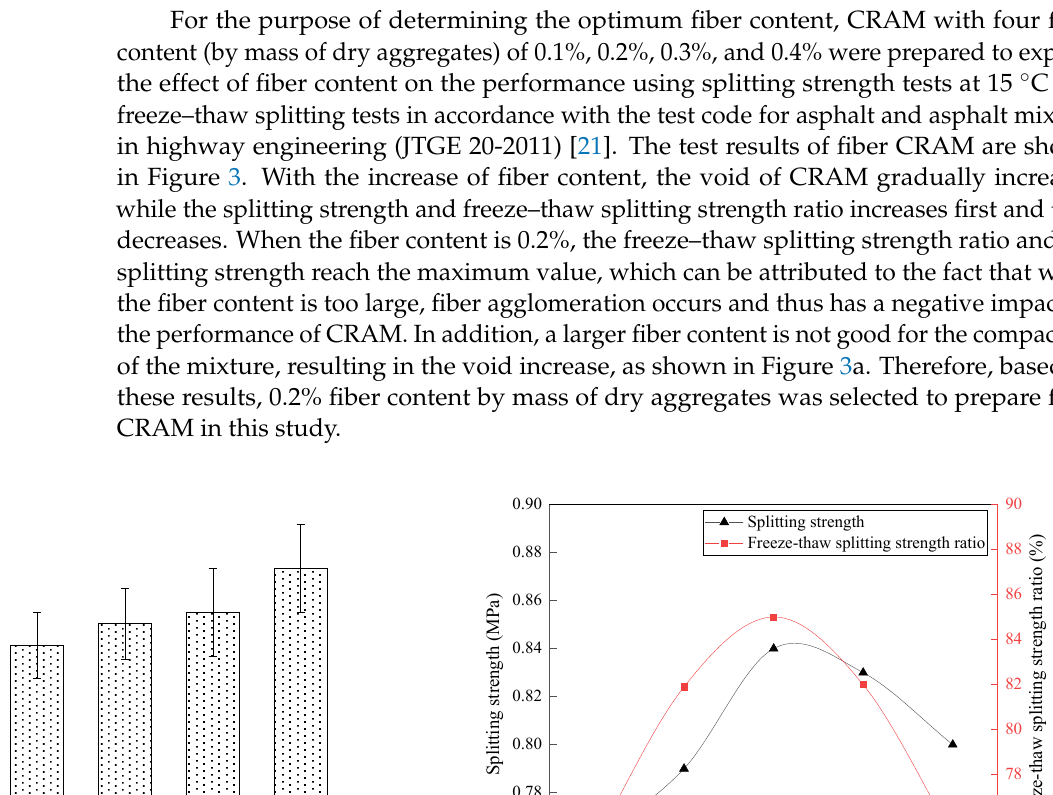
Figure 2. Final design gradation of CRAM.